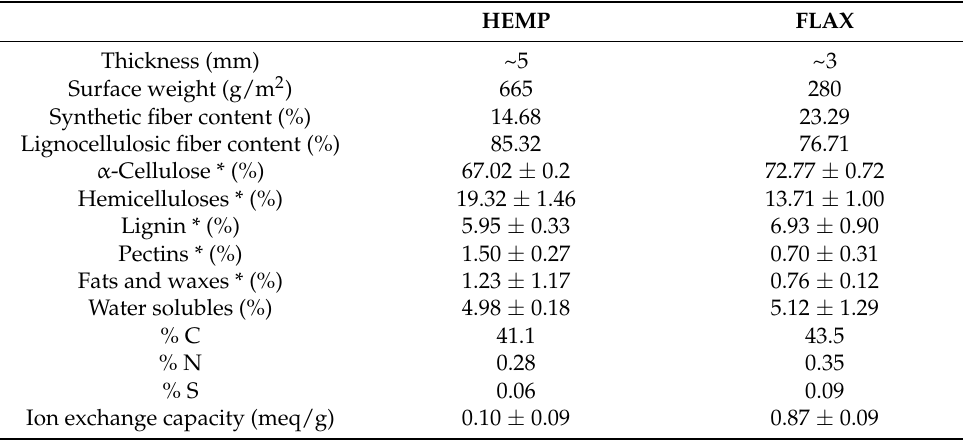
Table 1. Characteristics of hemp- and flax-based felts (washed